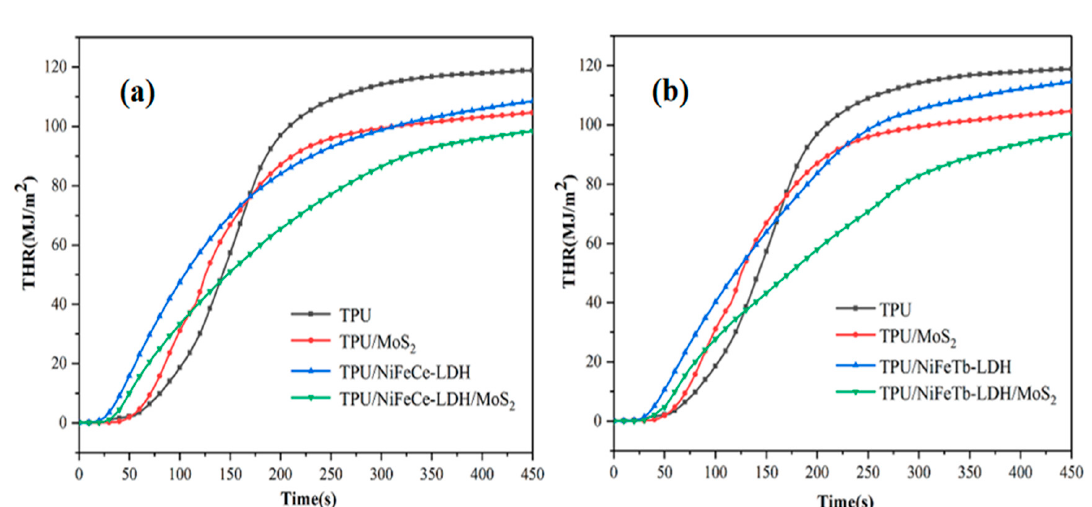
Figure 7. THR curves of pure TPU and TPU composites ( a,b ).